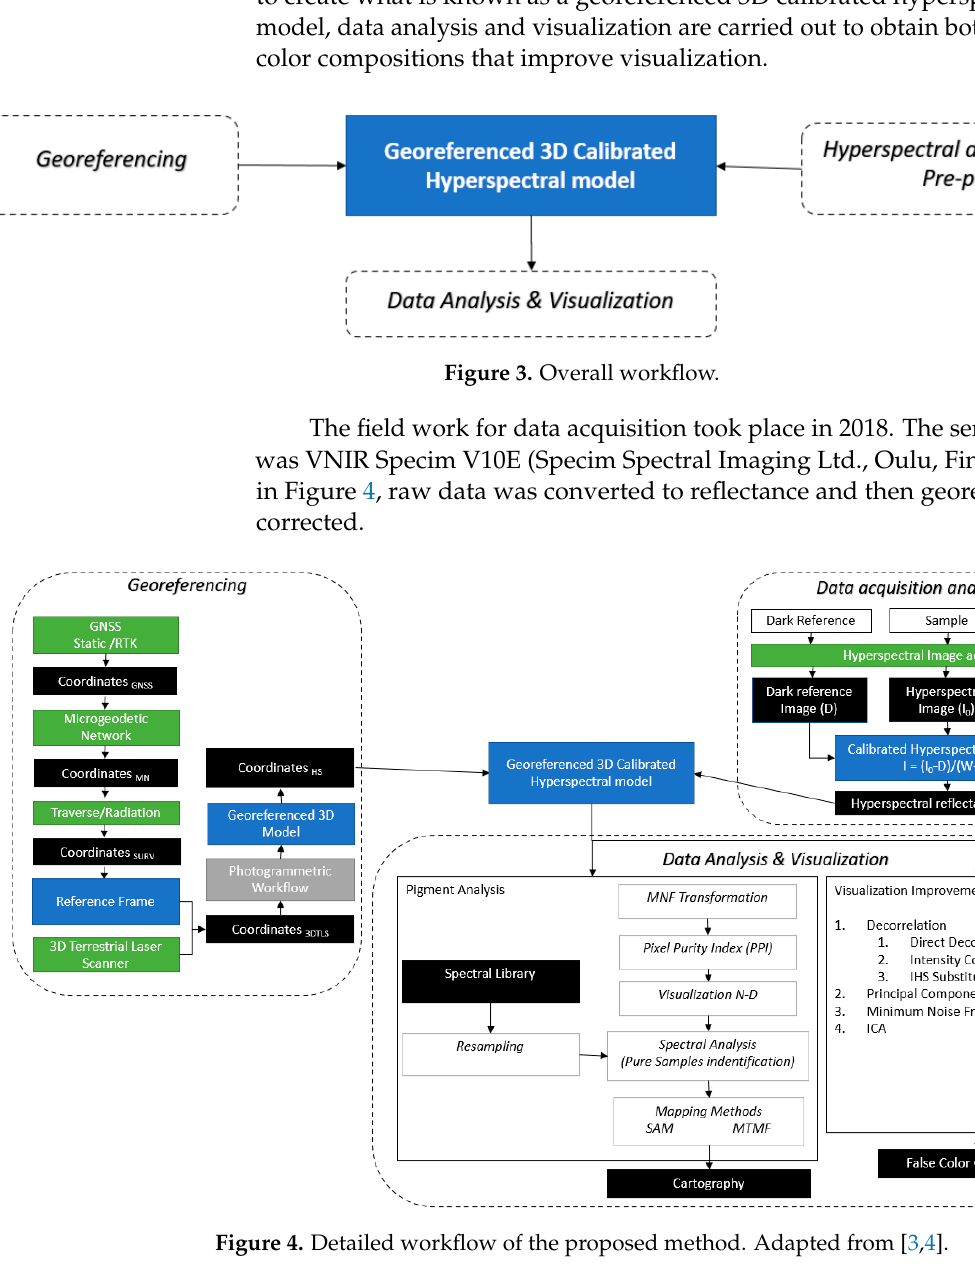
Figure 4. Detailed workflow of the proposed method. Adapted from [3,4].